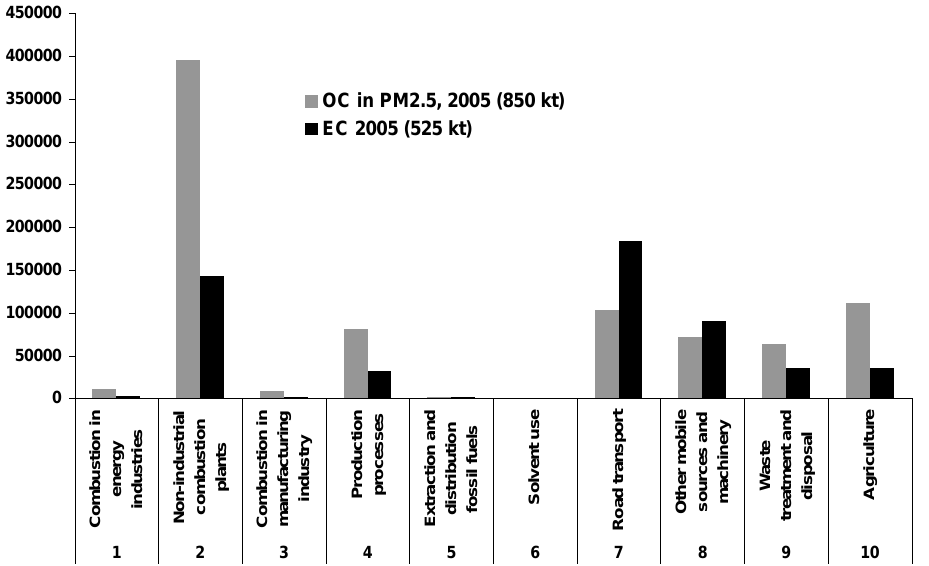
Fig. 22. EC and OC annual emission (tonnes) for Europe in 2005 by source